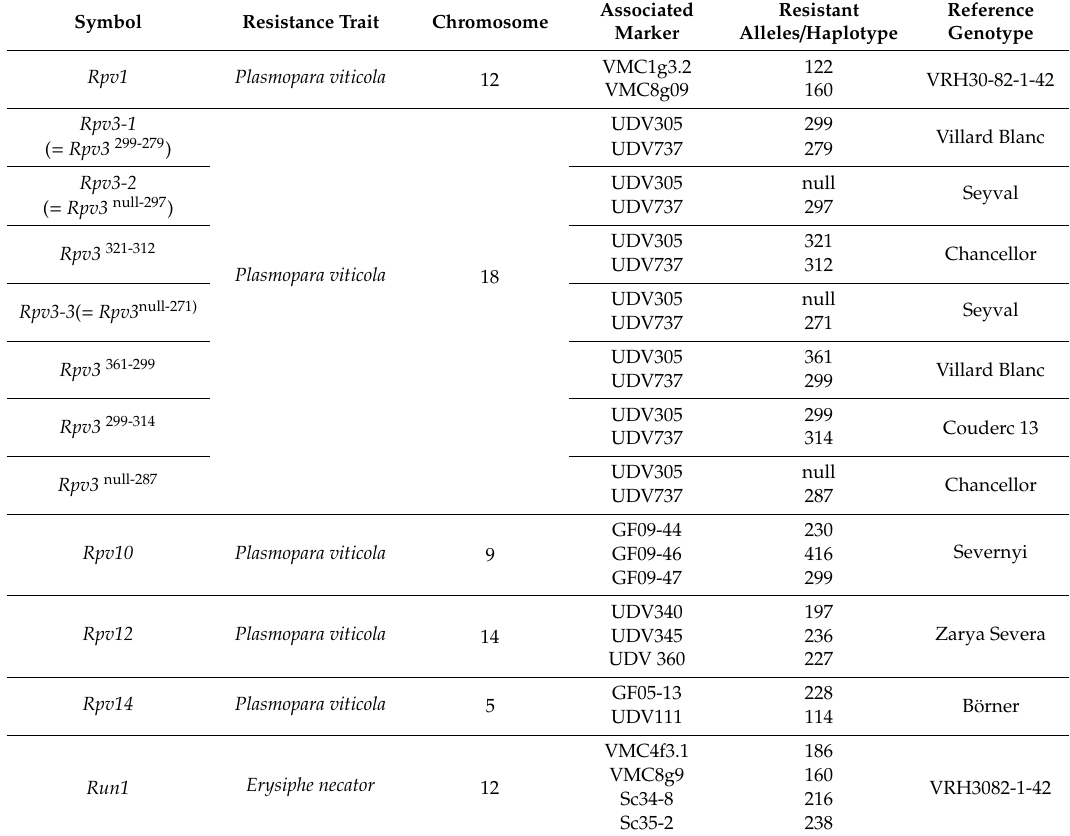
Table 2. Resistance ( R ) loci against Plasmopara viticola and Erysiphe necator with chromosome, used associated markers and their relative resistance alleles / haplotype, and used reference